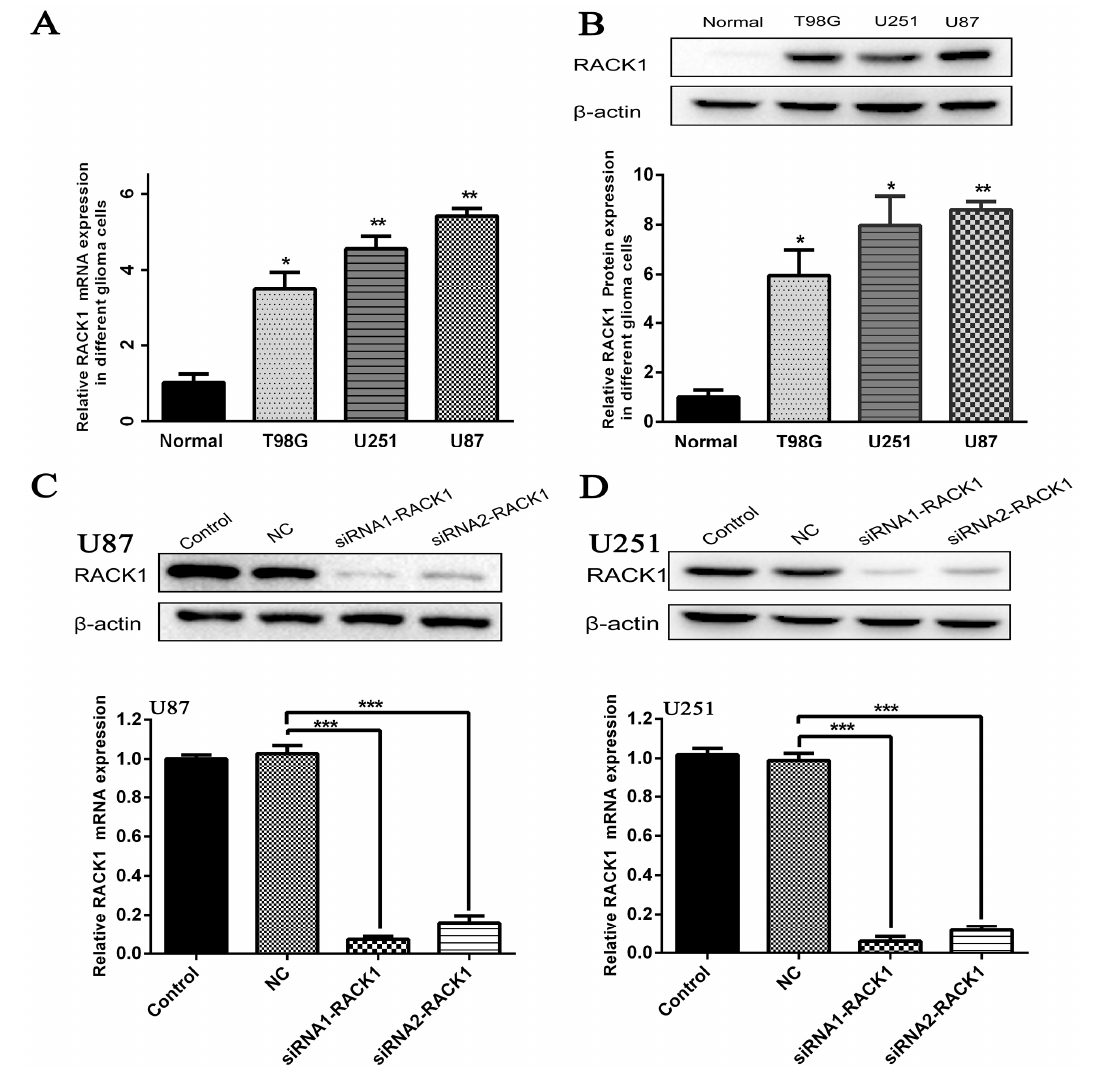
Figure 2. Silence of RACK1 expression in U87 and U251 cells by RACK1-siRNAs. ( A , B ) The mRNA and protein expression levels of RACK1 in normal tissues and three glioblastoma cell lines (T98G, U251, and U87) were detected by RT-PCR and Western blot; ( C , D ) The silencing effect of the siRNA1-RACK1 and siRNA2-RACK1 was confirmed by Western blot and RT-PCR in U87 and U251 cells. (* p < 0.05, ** p < 0.01, *** p < 0.001).